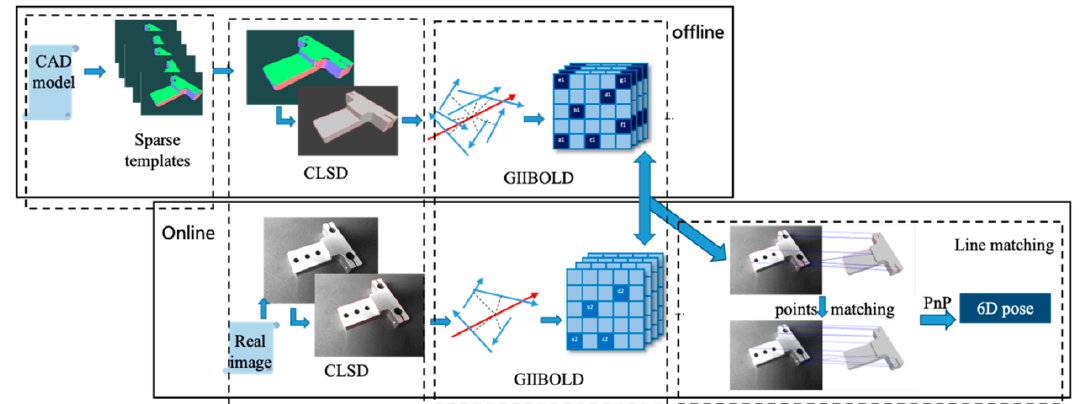
Figure 7. The overall workflow